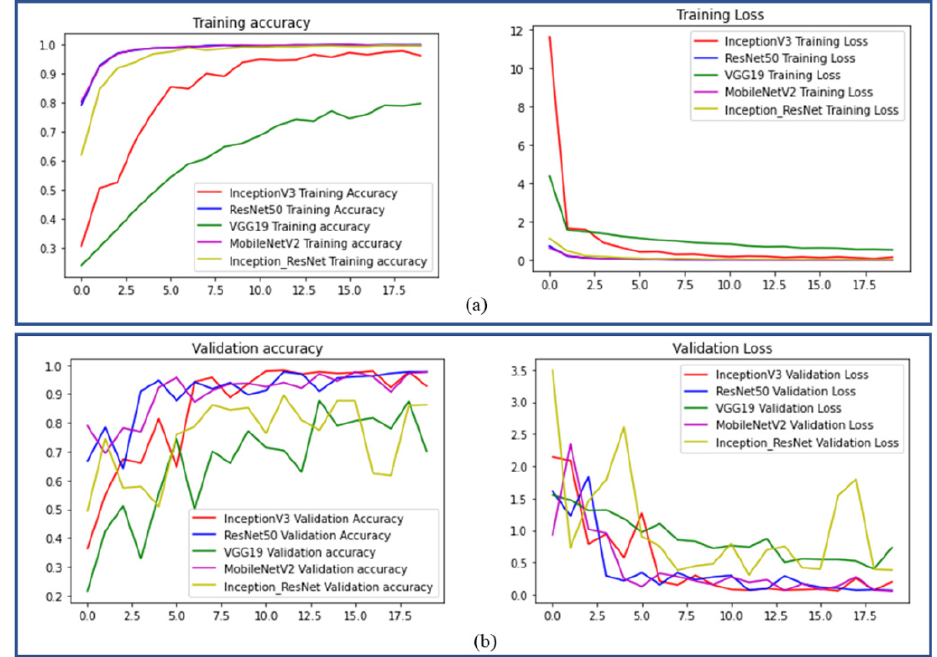
Figure 10. Training and validation graphs of the proposed work with different fine-tuned CNN transfer learning networks ( a ) training accuracy and loss curves ( b ) validation accuracy and loss curves.